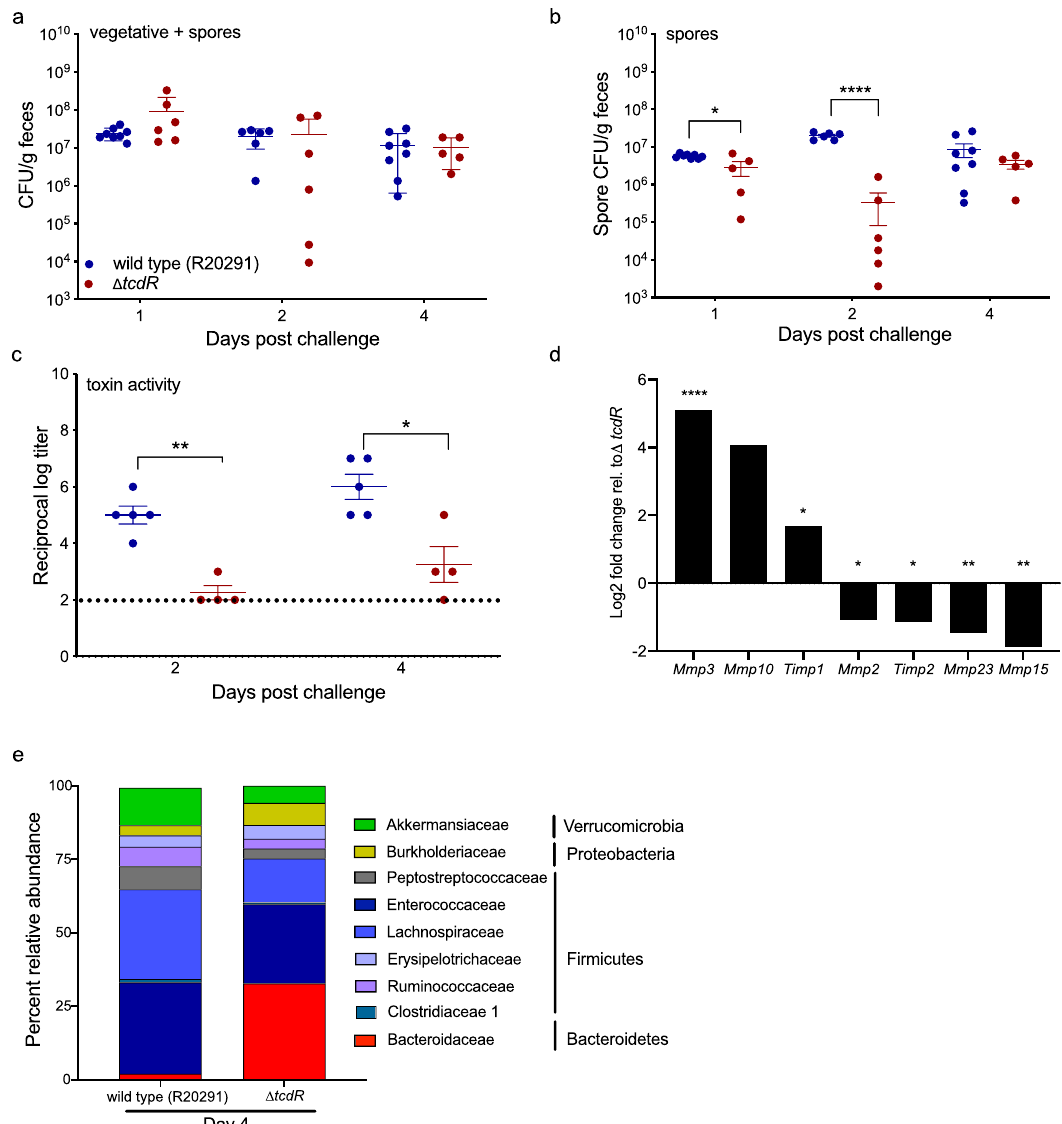
Fig. 6 C. dif fi cile R20291 toxin activity similarly shapes the host gut transcriptome and microbiota community structure in mice. a Total C. dif fi cile CFUs (vegetative and spores) in feces over time ( n = 8 mice for WT R20291 and n = 6 for or Δ tcdR mice; note that not every mouse provided a stool sample). b Fecal spore CFUs over time ( n = 6 – 8 mice per group per day, * p = 0.0318). c Toxin activity in the cecal content of R20291 or Δ tcdR mice, as assessed by the Vero cell cytotoxicity assay ( n = 5 mice per group on day 2, n = 4 mice per group on day 4, * p = 0.0383, ** p = 0.0055). d Log2 fold change of Mmp and Timp expression ( n = 3 mice per group) derived from NanoString transcriptome analysis (log2 fold change ±1 and adjusted p < 0.05). e Average percent relative abundances of 16S rRNA amplicon sequences from cecal tissue isolated at day 4 ( n = 5 mice per group). One-way Kruskal – Wallis test with Dunn ’ s correction for multiple comparisons was used to test for statistical signi fi cance for ( a ) and ( b ). A mixed effects model with the Geissner- Greenhouse correction and Sidak ’ s multiple comparisons test was used for ( c ). Signi fi cance was determined in ( d ) by NanoString nSolver Advanced analysis